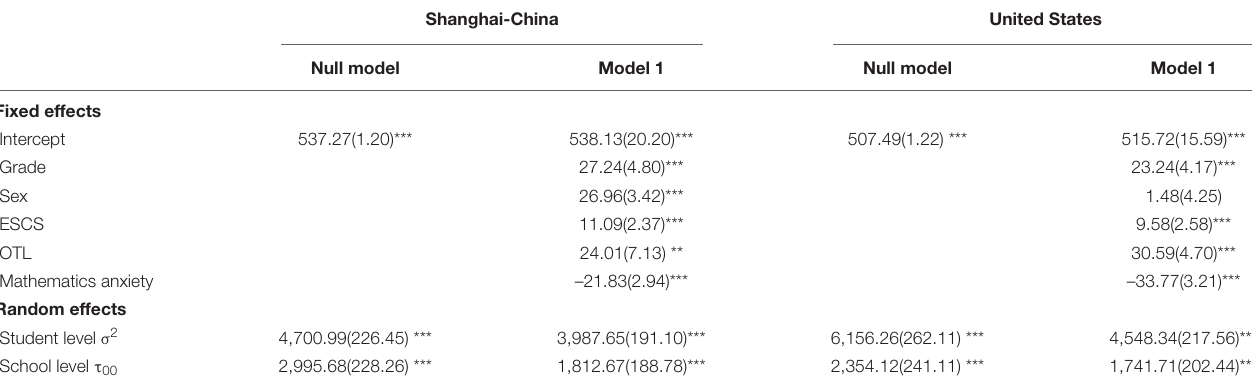
TABLE 3 | Effects of OTL on student problem-solving performance.